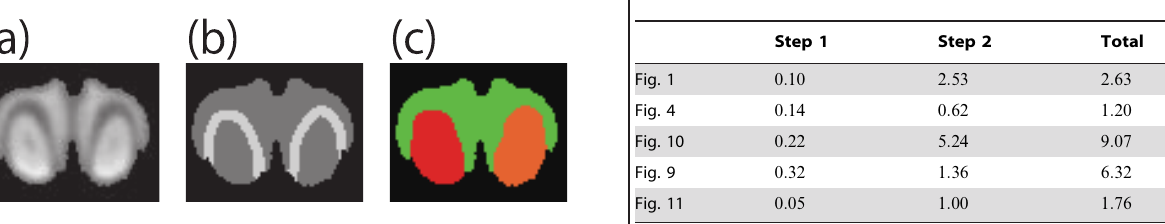
Figure 11. Front teeth of mouse. (a) is the input CT image. The white areas in (b) are the ROIs. (c) is the result of the proposed method. doi:10.1371/journal.pone.0031116.g011 PLoS ONE |